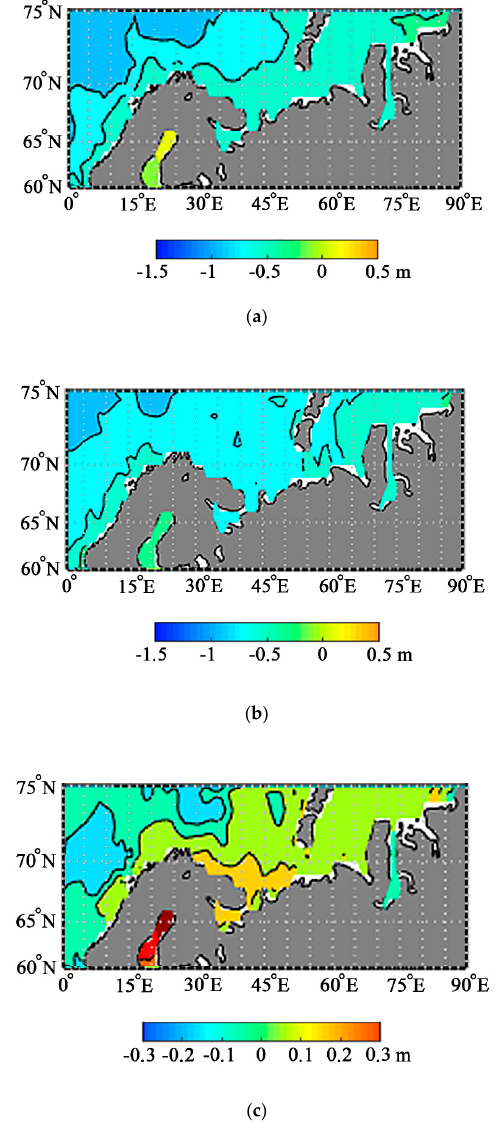
Figure 2. Sea surface height field on July 15, 2013: ( a ) calculation without data assimilation (DA); ( b ) calculation with DA; ( c ) difference between sea surface heights (SSHs) in calculations with and without DA.